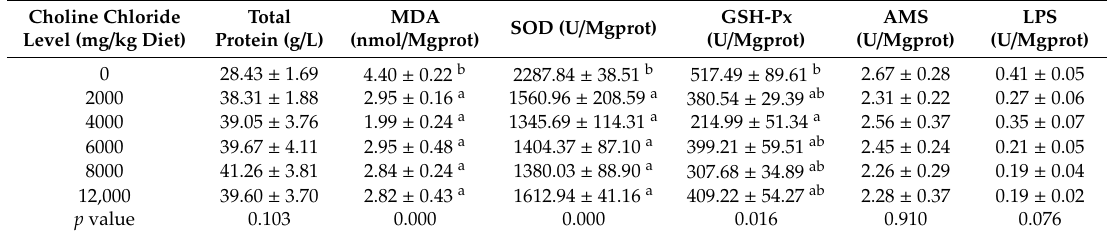
Table 5. E ff ects of di ff erent dietary choline chloride levels on the total protein content, MDA content and activities of SOD, GSH-Px, AMS, and LPS in the hepatopancreas of L. vannamei (n = 4, mean ± SE). Choline Chloride Level (mg / kg